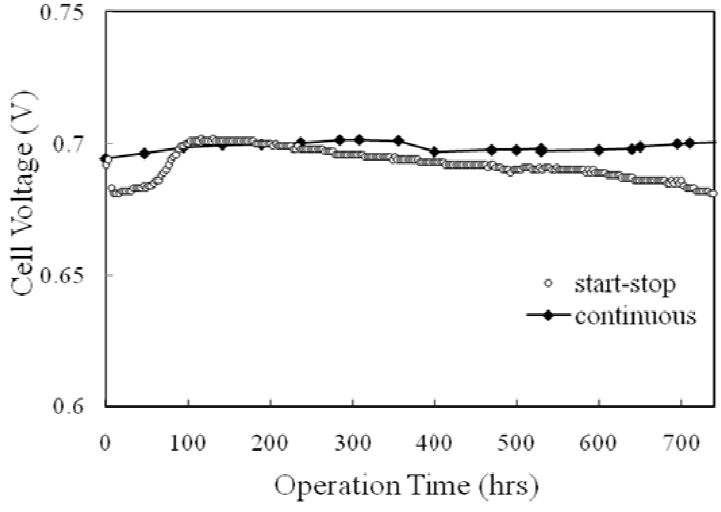
Figure 11. MEA lifetime. Continuous and start–stop mode operation, 150 °C, start–stop operation: operation for 2 h and stopped for 40